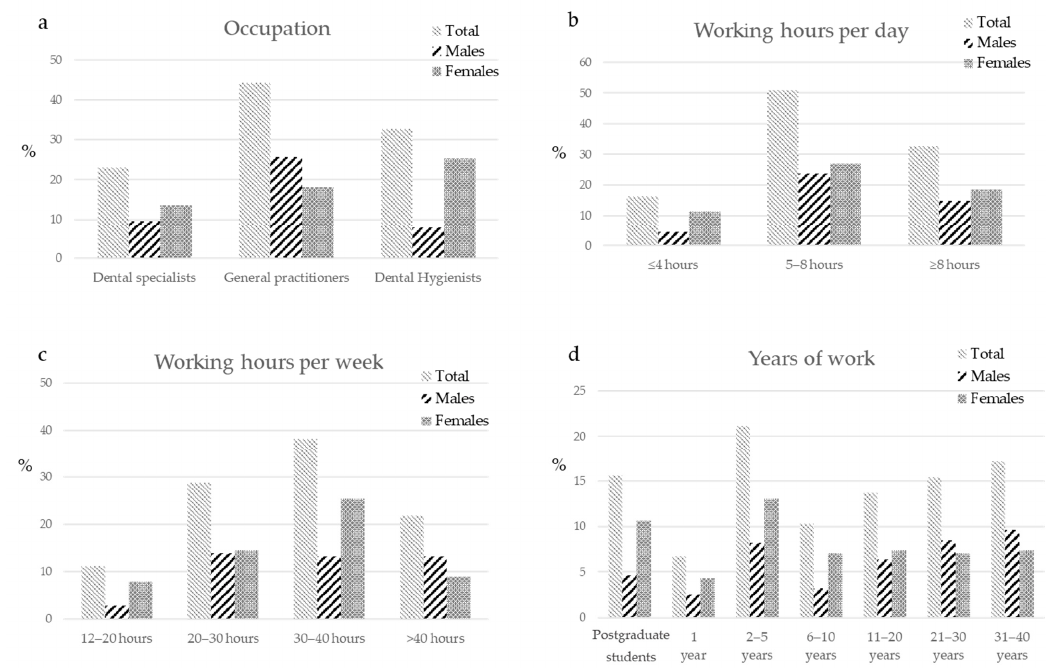
Figure 2. Occupational distribution of surveyed operators, expressed in percentages. ( a ) The population was constituted by a higher percentage of general practitioners (approximately 50%), followed by dental hygienists (approximately 30%) and dental specialists (approximately 20%). ( b ) Most of the operators worked more than 5 h per day and ( c ) more than 30 h/week. ( d ) The years of work was uniformly distributed.